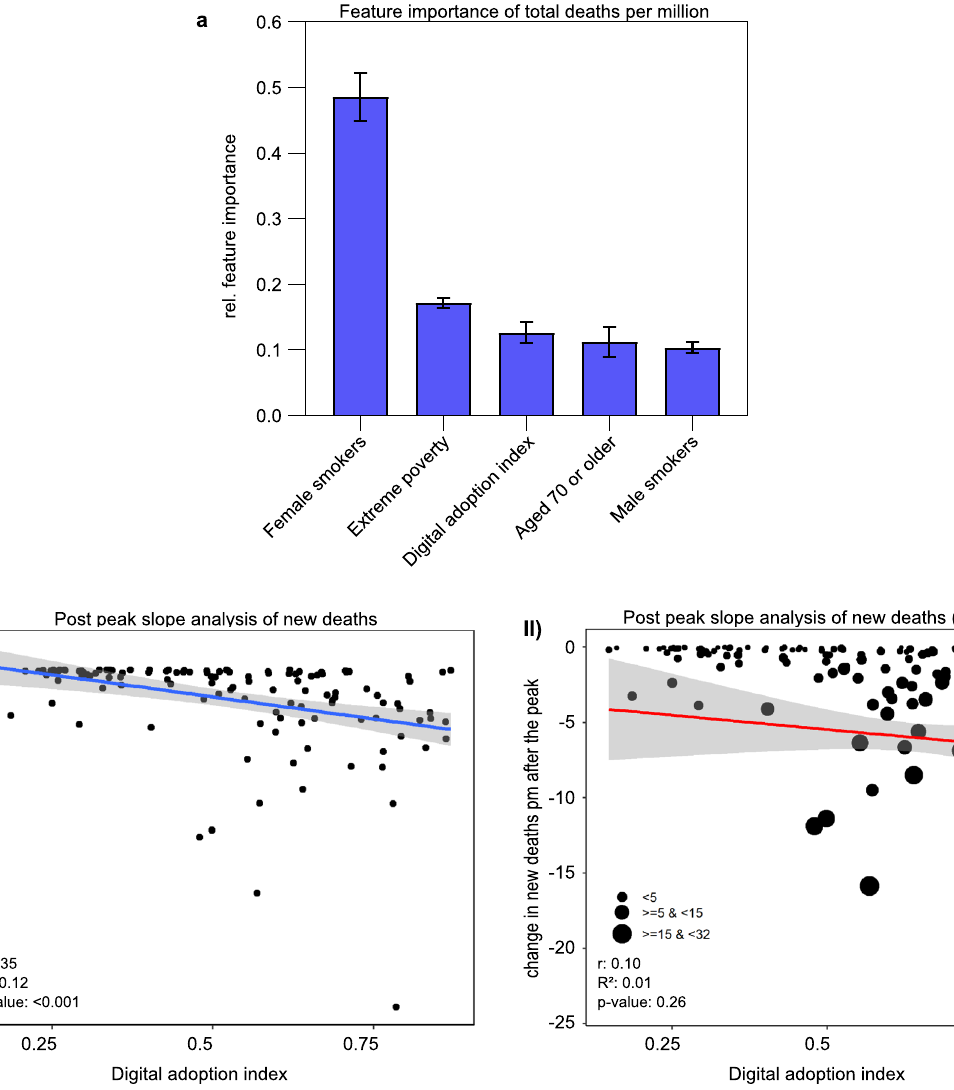
Figure 3. The impact of digital adoption on the development of COVID-19 deaths. ( a ) Gradient tree boosting results show the top five important features for peak COVID-19 deaths in 2020. Relative feature importance was normalized, and the sum was set to 1.0. Data are expressed as mean ± standard error of the mean. ( b ) Regression results show the effect of the DAI on reducing new deaths pm during the post-peak period in 2020–2021. (I) Countries with higher DAI could significantly reduce their number of new COVID-19 deaths (7-day-smoothed) months after the peak. (II) In the weighted regression analysis, the significant effect of the DAI on reducing deaths is no longer visible. The blue (I) and red (II) lines indicate the linear fits of regression analyses. The area of the 95% confidence interval is shaded gray. DAI is expressed as an arbitrary Regression analysis shows the impact of digitalization on post-peak COVID-19 deaths (Table 1; Fig. 3b). Higher DAI was associated with a significant decrease in new deaths pm, resulting in approximately 5.53 ( p < 0.001) fewer deaths pm after the peak in 2020/2021. The slope expresses the decline in cases after reaching the peak for each country. We performed another regression analysis weighted by the decrease in the number of deaths, showing the same trend (β = − 3.79/pm; p = 0.207). The influence of digitalization on the stringency of government measures. The most important features identified with GTB and associated with SI were hospital beds per thousand people (0.24, SEM ± 0.01), followed by DAI (0.22, SEM ± 0.01). Other informative features included extreme poverty (0.19, SEM ± 0.01), male smokers (0.17, SEM ± 0.01), and diabetes prevalence (0.17, SEM ± 0.01) (Fig. 4a). The final regression model shows that, on average, countries with a higher DAI adopted slightly stricter policy measures during the first year of the pandemic (β = 4.86; p < 0.01) (Fig. 4b). After plotting DAI against mean SI, we identified three trends in the data and grouped the DAI accordingly. Then, the estimated effect of each group (low, medium, and high DAI) was analyzed by including the DAI:class interaction term in the model. Subse- quent regression analyses of all three classes showed that the interaction of DAI and its high class (> 0.68) could